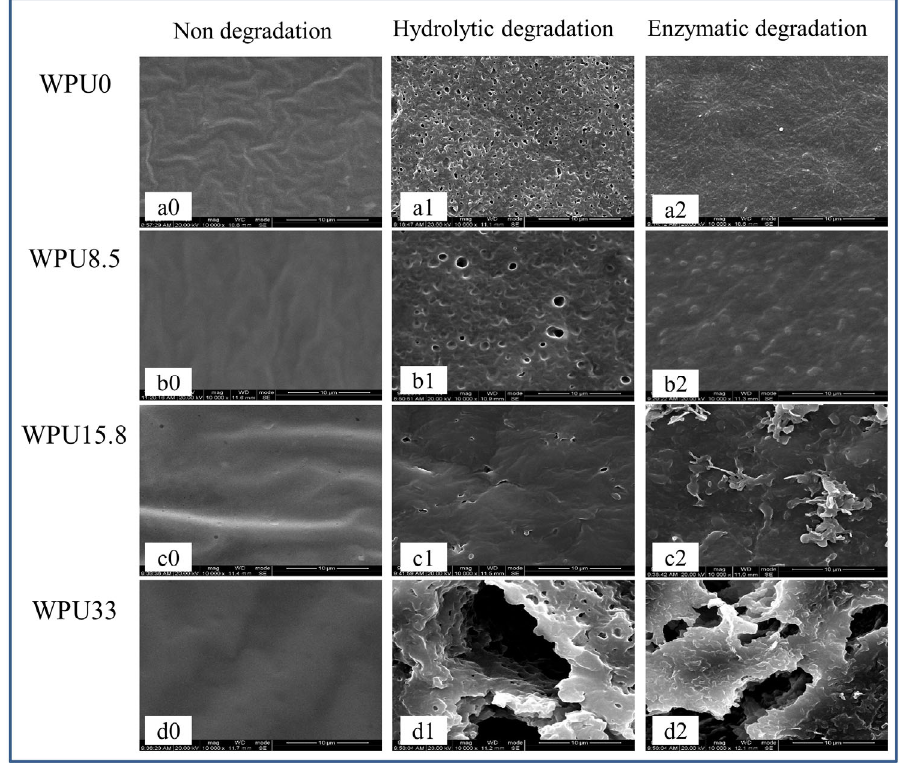
Figure 4. Surface morphology of WPUn. ( a0 , b0 , c0 , d0 ): WPUn non ‐ degraded; ( a1 , b1 , c1 , d1 ): WPUn degraded in PBS; ( a2 , b2 , c2 , d2 ): WPUn degraded in PBS + lipase PS. Scale bar = 10 μ m.